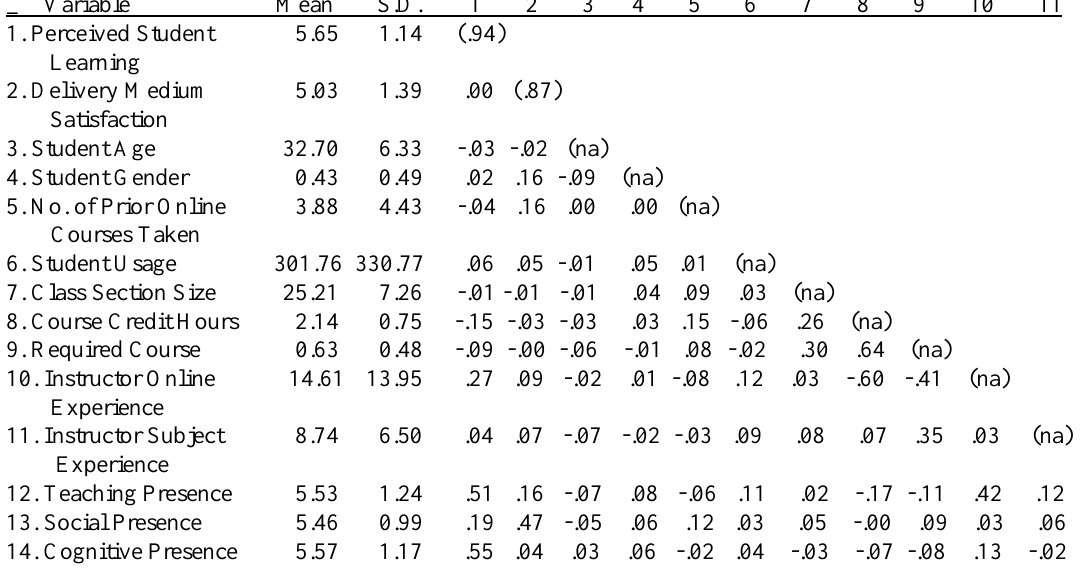
Table 2. Descriptive Statistics and Correlations